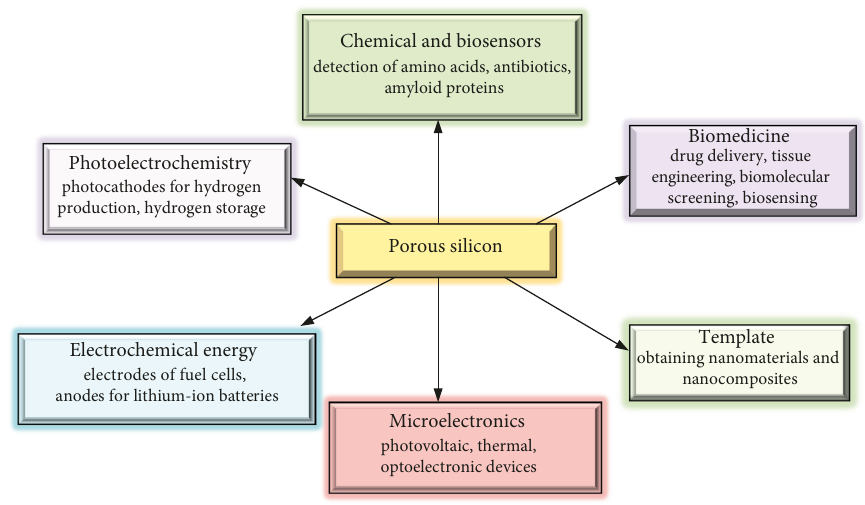
Figure 1: Applications of porous silicon.